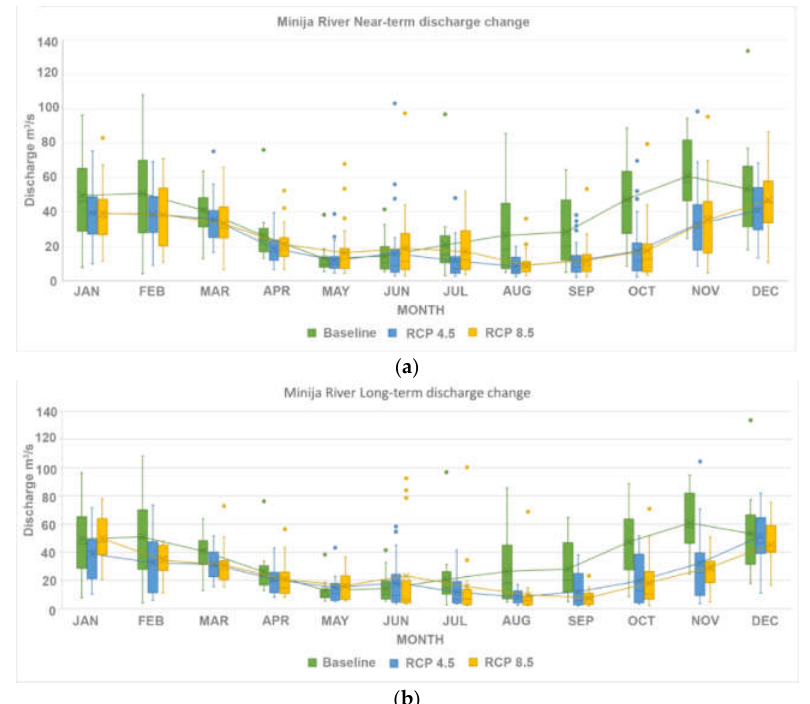
Figure 8. Change in the hydrological regime for Minija River (in the mouth) for each month under RCP 4.5 and RCP 8.5, compared to the baseline period: ( a ) near-term projection; and ( b ) long-term